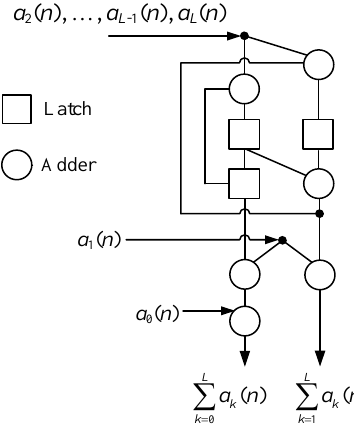
Figure 2. The computational structure for first-order moment.